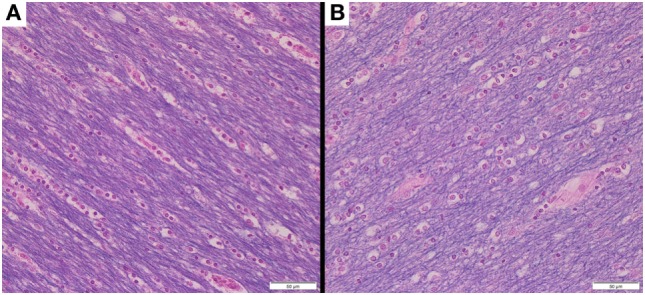
Following the conclusion of our MRI experiments, brain tissue sections were obtained from deep white matter regions of (A) Subject 1 and (B) Subject 2. Each tissue section was stained with Eriochrome Cyanine R and photographed at 400× magnification (note: 50-µm scale bar in bottom right of each panel), suggesting that the tissue in general (all colors) and myelin in particular (blue) were reasonably well-preserved throughout the 1,032 h experimental time-course (during which all MRI measurements were acquired).